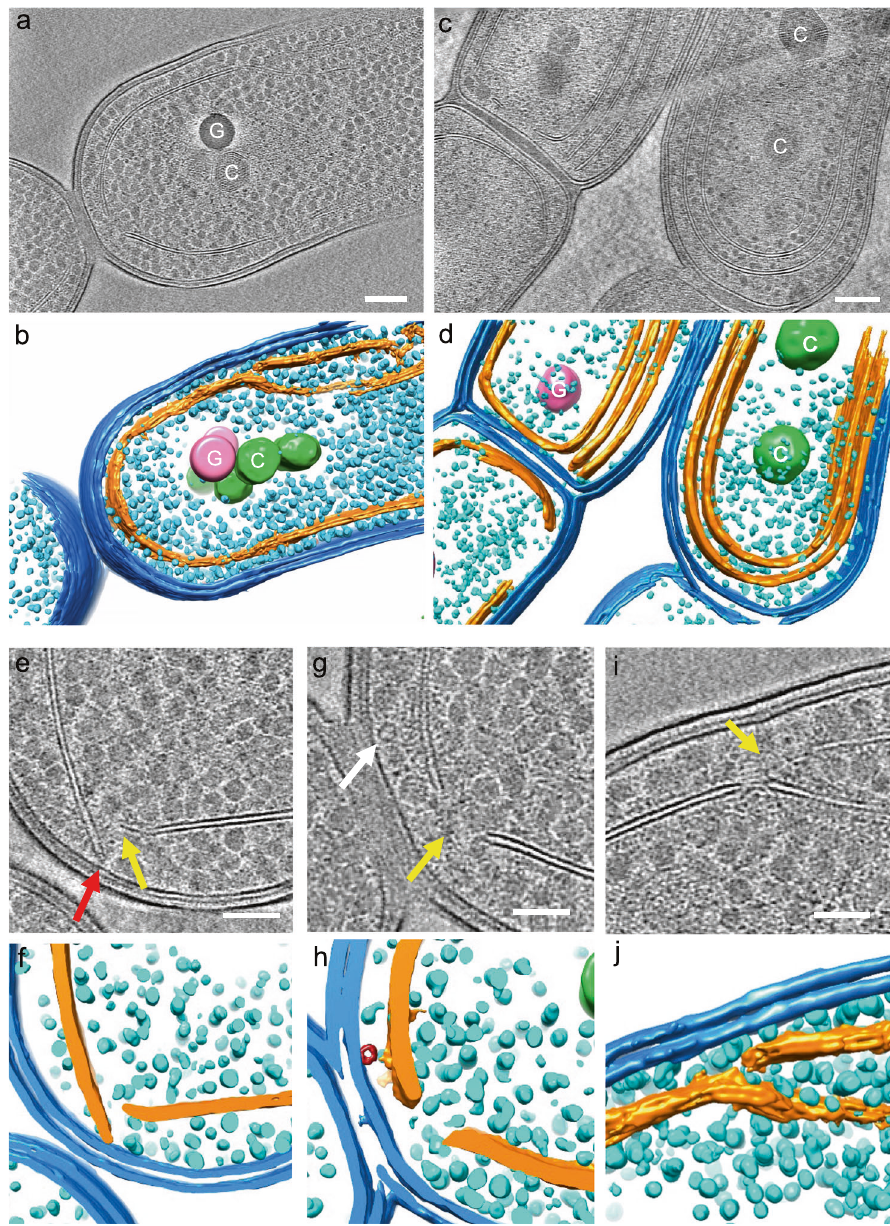
Fig. 2 Cryo-electron tomography (ET) analysis of frozen-hydrated Synechococcus cell lamella. Tomographic slices ( a , c ) and segmented volumes ( b , d ) of cyanobacteria cells grown under high light (HL) ( a, b ) and these HL-grown cells transferred to low light (LL) condition for 1 − 2 days ( c , d ). Tomographic slices at high magni fi cation ( e , g , i ) and segmented volumes ( f , h , j ) of cyanobacteria cells grown under HL. Outer and plasma membranes are in blue, thylakoid membranes in gold, glycogen granules in cyan, carboxysomes ( “ C ” ) in green, and large dense granules ( “ G ” ) in pink, most likely the polyphosphate bodies. Yellow arrows point to the gaps between two thylakoid membrane edges for the emergence of newly synthesized thylakoid membrane rafts (Supplementary Fig. 5). The red arrow points to the thylakoid tip located in the vicinity of the plasma membrane, but not connecting to it. The white arrow points to the tubular structures. Scale bars, 200 nm in panels ( a , c ), 100 nm in panels ( e , g , I ). Single slice images have a thickness of 2.49 nm and the tomographic slices images are constructed from superimposed serial slices with the same thickness. Representative Cryo-ET images were derived from at least three biologically independent preparations with similar Closer views of the tomogram revealed that the extra thylakoid to develop sacs of thylakoid layers. The thylakoid membranes of fragment close to the plasma membrane did not form connections Synechococcus are often discontinuous, as several perforations were with the adjacent continuous thylakoid layer (also refers to the pre- observed in the thylakoid lamellae (Fig. 2g, h, Supplementary existing thylakoids) that is curved towards the central cytoplasm Fig. 8, and Supplementary Movie 7), consistent with the previous (Fig. 2i, j). This indicates that thylakoid biogenesis in Synechococcus electron tomography of thylakoids in Synechococcus and occurs most likely at the peripheral sites of the cytoplasm close to Chlamydomonas 17,30 . This membrane organization may provide a means for the transport of ribosomes and synthesized proteins to the plasma membrane. Expansion of the new thylakoid layer likely pushes the existing thylakoid lamellae toward the central cytoplasm